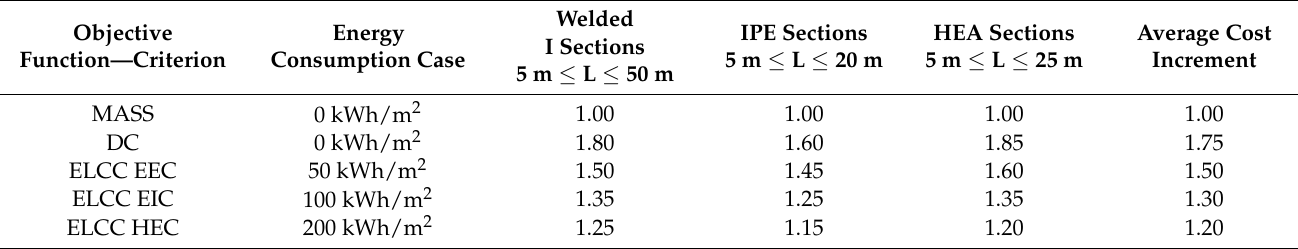
Table 4. Mass increment factors related to the calculated masses of different criteria and different steel sections.